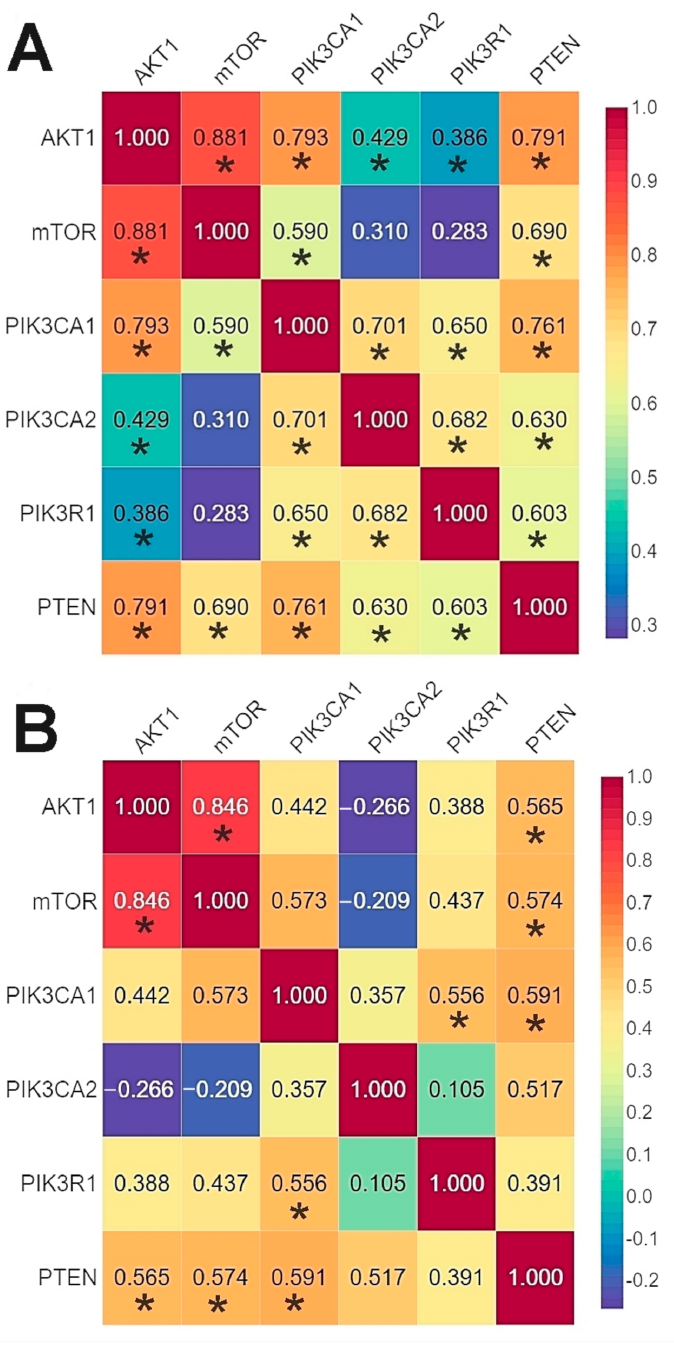
Figure 6. Correlation between the expression level of the studied genes using Spearman’s rank correlation coefficient: ( A ) in the group of patients without mutations; ( B ) in the group of patients with mutations * p <